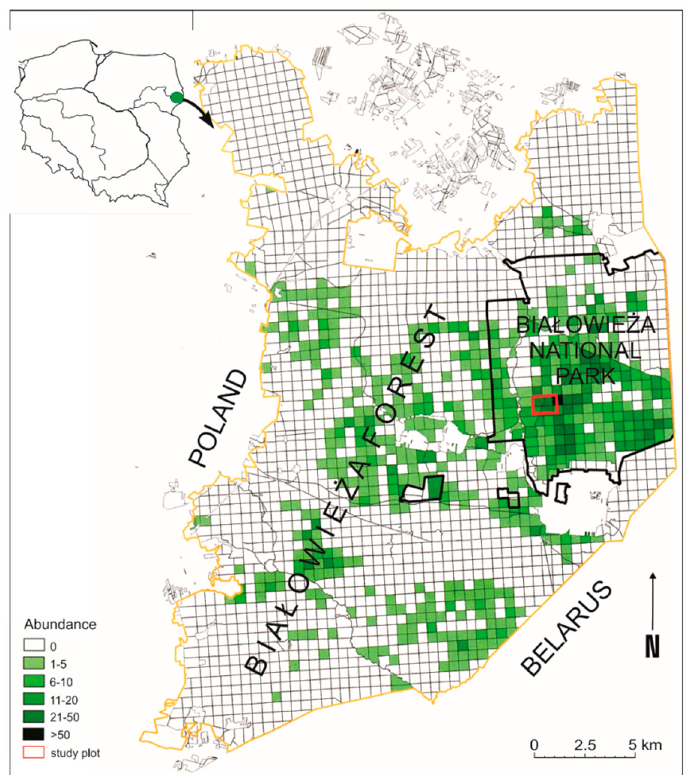
Figure 1. Location of the study plot on the background of the abundance of Quercus robur monumental trees (trunk diameter at 1.3 m above the ground > 120 cm) in Bia ł owie ż a Primeval Forest, Northeastern Poland; abundance (number of Q. robur monumental trees/forest compartment) according to [60].